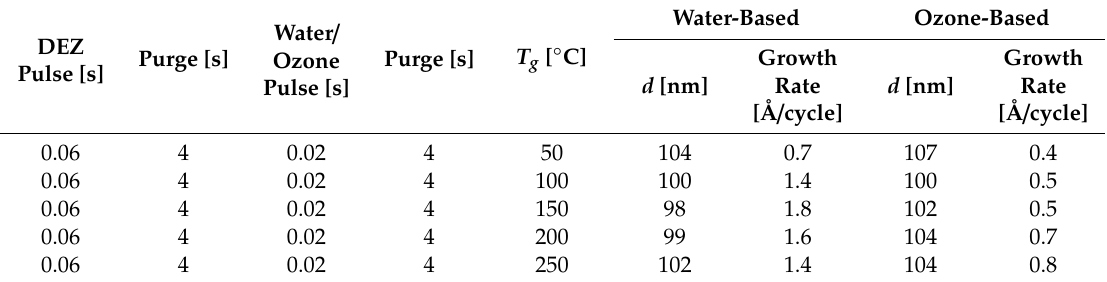
Table 1. Parameters of atomic layer deposition (ALD) processes applied to obtain ZnO layers with use of diethylzinc (DEZ) and either water or ozone as precursors.